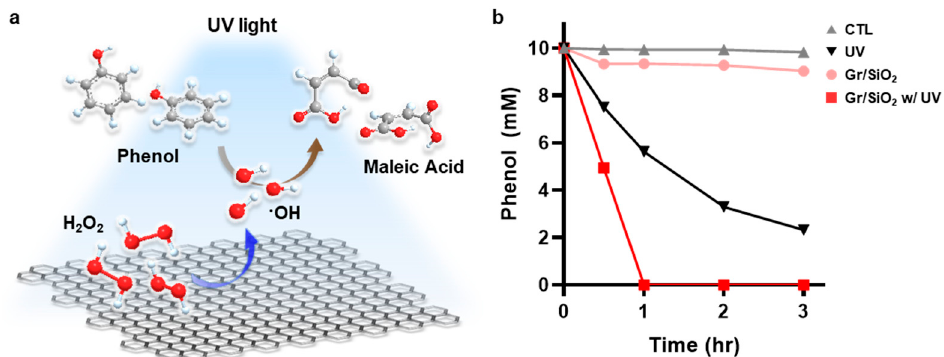
Figure 2. UV exposure enhances the catalytic effect of graphene on phenol degradation. ( a ) Schematic illustration of phenol degradation under UV exposure with graphene as the AOP catalyst. ( b ) Degradation of phenol by CTL (without graphene and UV), UV (UV irradiation), Gr/SiO 2 (graphene), and Gr/SiO 2 w / UV (graphene with UV irradiation) within three hours.